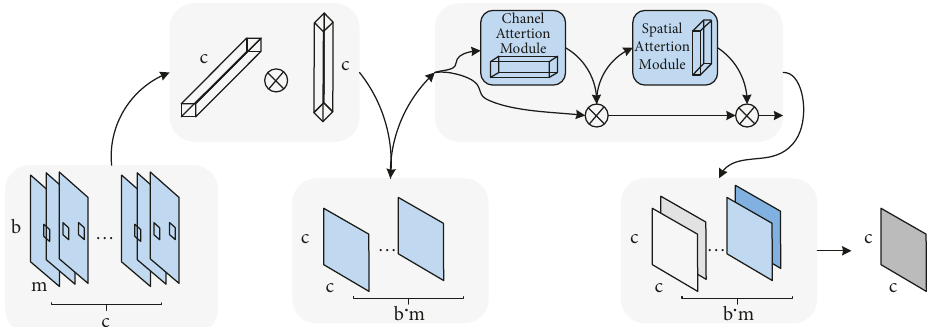
Figure 2: Bilinear hybrid attention mechanism module (IPM-SE).